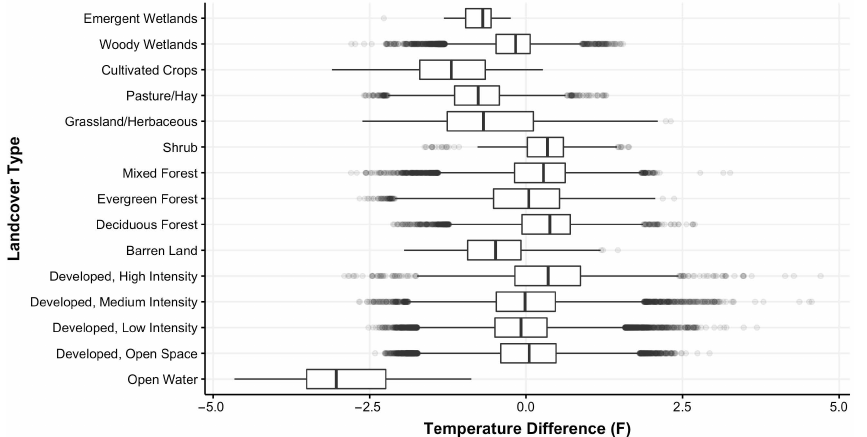
Figure 5. Pixel-level difference between predicted temperatures and evening CAPA Heat Watch temperatures across land-cover types.